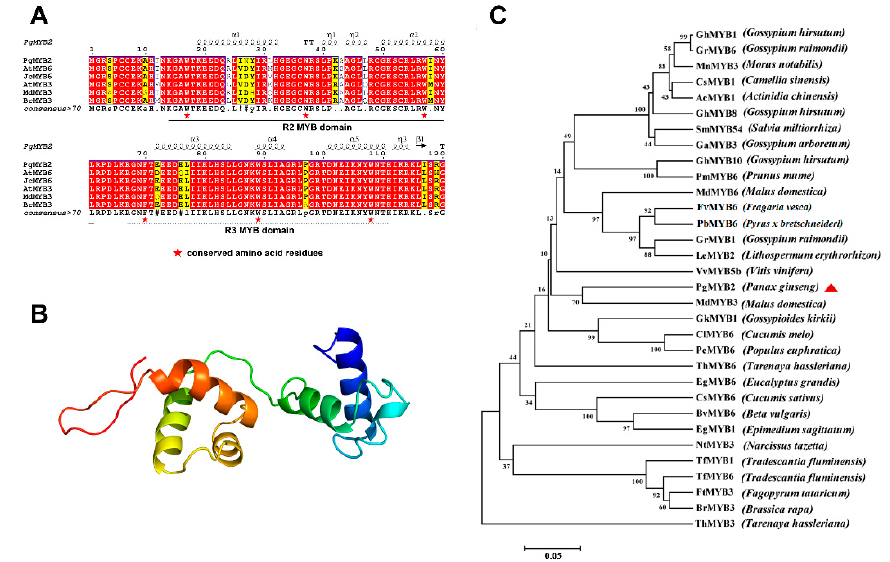
Figure 2. Bioinformatics analysis of PgMYB2 amino acids. ( A ) Amino acid sequence alignment between PgMYB2 and other plant MYB proteins. Red stars indicate conserved tryptophan (W) and phenylalanine (F) residues. ( B ) The three-dimensional structure diagram of the PgMYB2, constructed by Swiss-Model software. ( C ) The phylogenetic tree of PgMYB2 with 31 other plant MYB proteins was built using the MEGA 7.0. The procedure performed 1000 repetitions under the Neighbor-Joining method. Full names of the respective plant species are mentioned in brackets. All the accession